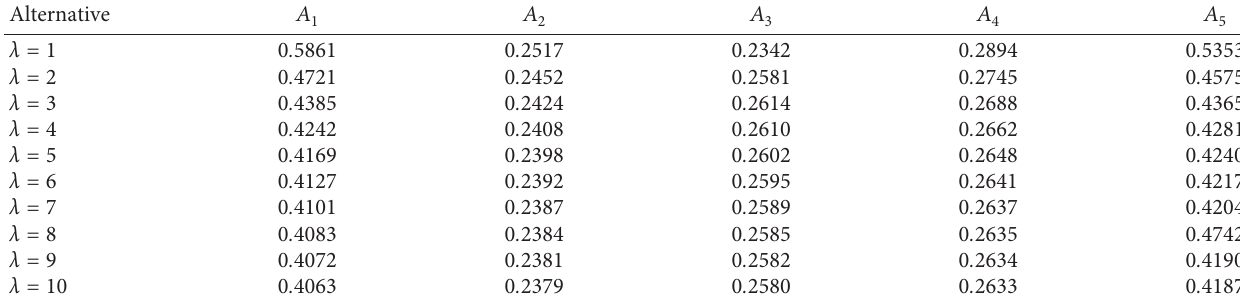
� 0 . 725 , θ � 2 . 04 , and β � 0 . 717). i ( α